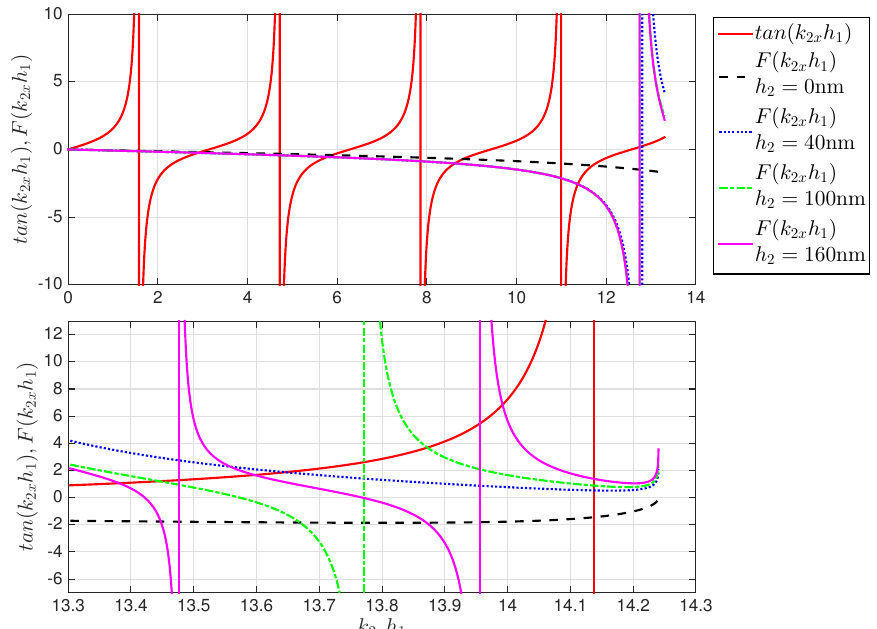
Figure 11. Graphical determination of tan ( k 2 x h 1 ) and F ( k 2 x h 1 ) for guided modes in ( a ) ( 0, h 1 ) and ( b ) ( 0, h 1 + h 2 ) with different values of h 2 . Here, the incident energy of electrons is fixed at E = 94 meV. The other parameters are the same as those in Figure